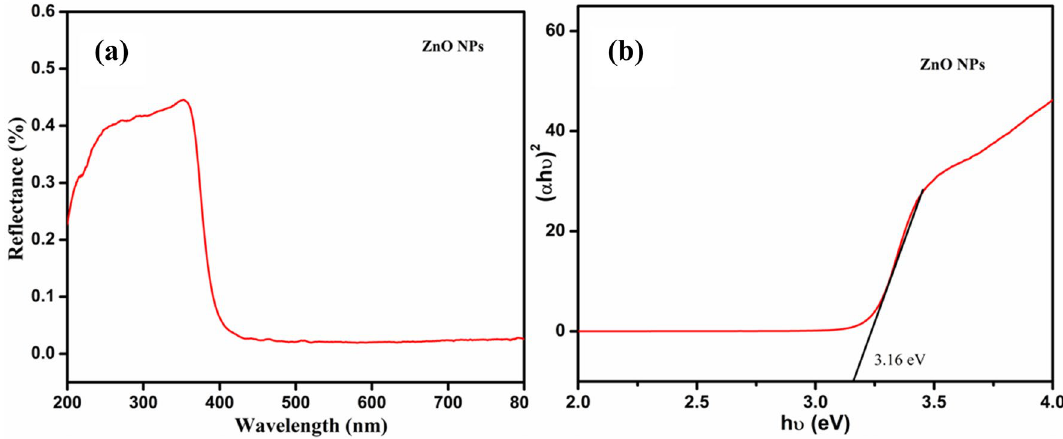
Fig. 3 a DRS spectra of ZnONPs b Tauc’s